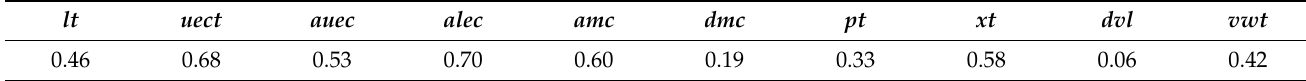
Table 1. Plasticity indices of leaf structural characteristics.